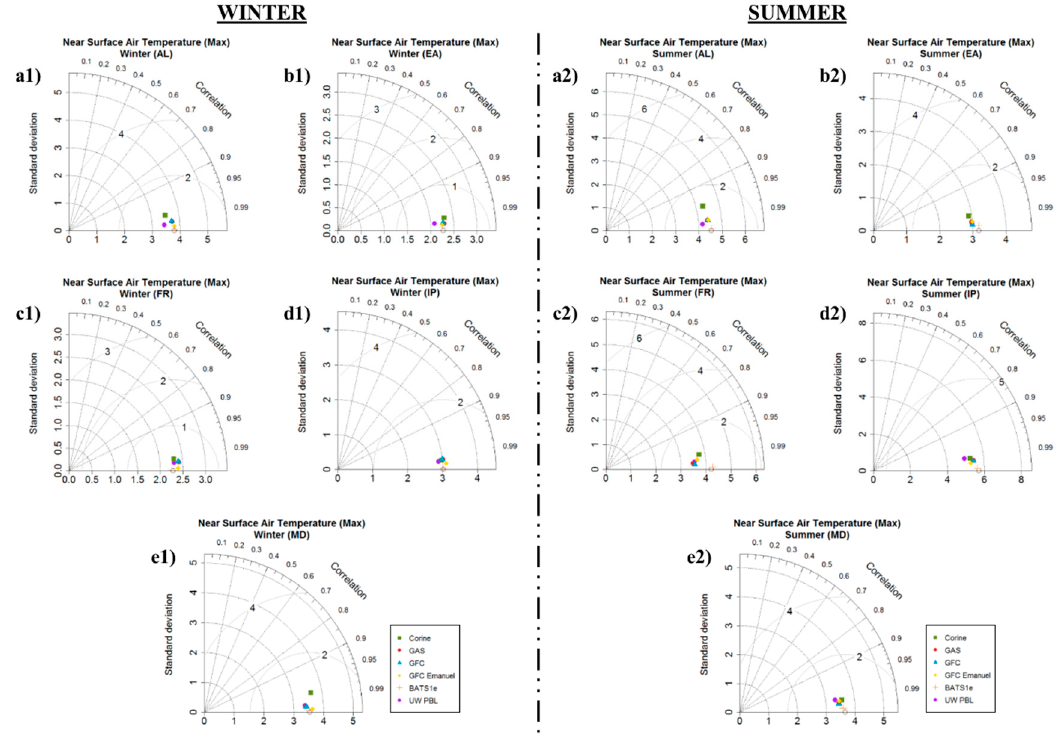
Figure 9. Taylor diagrams exploring the model’s performance for near surface max temperature over the five sub-regions (a → AL, b → EA, c → FR, d → IP, e → MD) during winter and summer. The markers in Taylor diagrams represent the different simulations. The default simulation is being used as reference